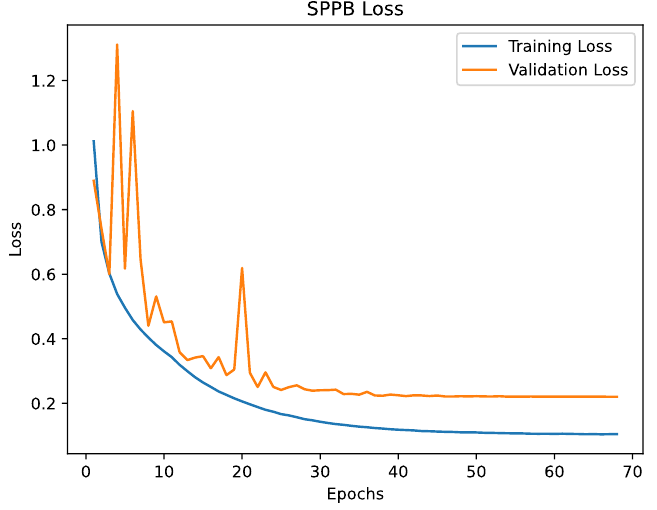
Figure 6. The loss of the SPPB model. For the first 25 epochs the loss indicates that the learning rate the TUG model. For Figure 3. The loss of Figure 4. The loss of the SPPB model. For is slightly too large. From epoch 25 the progress shows an asymptotic the first 25 epochs the loss indicates that the first 25 epochs the loss indicates that the learning rate is slightly too large. From the learning rate is slightly too large. From epoch 25 the progress shows an asymptotic epoch 25 the progress shows an asymptotic behaviour. Figure 5. The accuracy of the TUG model. According to the progress of the loss, the accuracy fluctuates in the first 25 epochs and shows an asymptotic behaviour after epoch 25. The best validation accuracy score was 95.89 % at epoch 52.